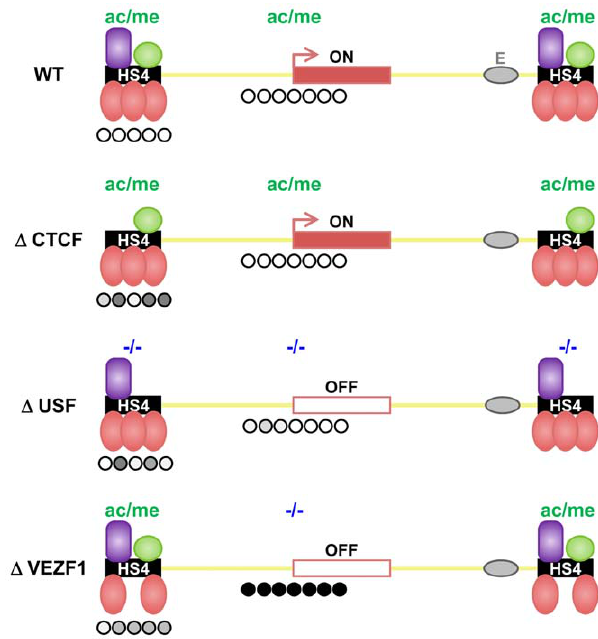
Figure 9. Shielding of a transgene by the multi-component HS4 barrier element. The observed effects of insulator protein binding site mutations on the DNA methylation (this study), histone modification [14] and transcriptional status (this study and [12]) of a transgene insulated by HS4. A schematic representation is shown where HS4 harbors one CTCF (purple), one USF (green) and three VEZF1 (red) binding sites. Transcriptional activity of the reporter gene is indicated with an arrow. The histone modification status is depicted above each transgene, where high and minimal levels of H3ac and H3K4me2 are represented as ac/me and -/-, respectively. The DNA methylation status of the promoter and upstream insulators is indicated below each transgene where open and filled circles represent unmethylated and methylated bases, respectively. Shades of methylation are an approx- imation of the data presented in Figure 1 and Figure 2. Mutation of the CTCF site disrupts enhancer blocking activity [9] but has no effect on barrier activity of HS4. USF site mutation disrupts the recruitment of active histone modifications, resulting in transcriptional silencing. The promoter remains unmethylated in USF mutants due to the action of VEZF1. VEZF1 site mutations abrogate barrier activity despite USF- mediated recruitment of histone modifications remaining intact. VEZF1 mutants are characterized by complete promoter methylation.